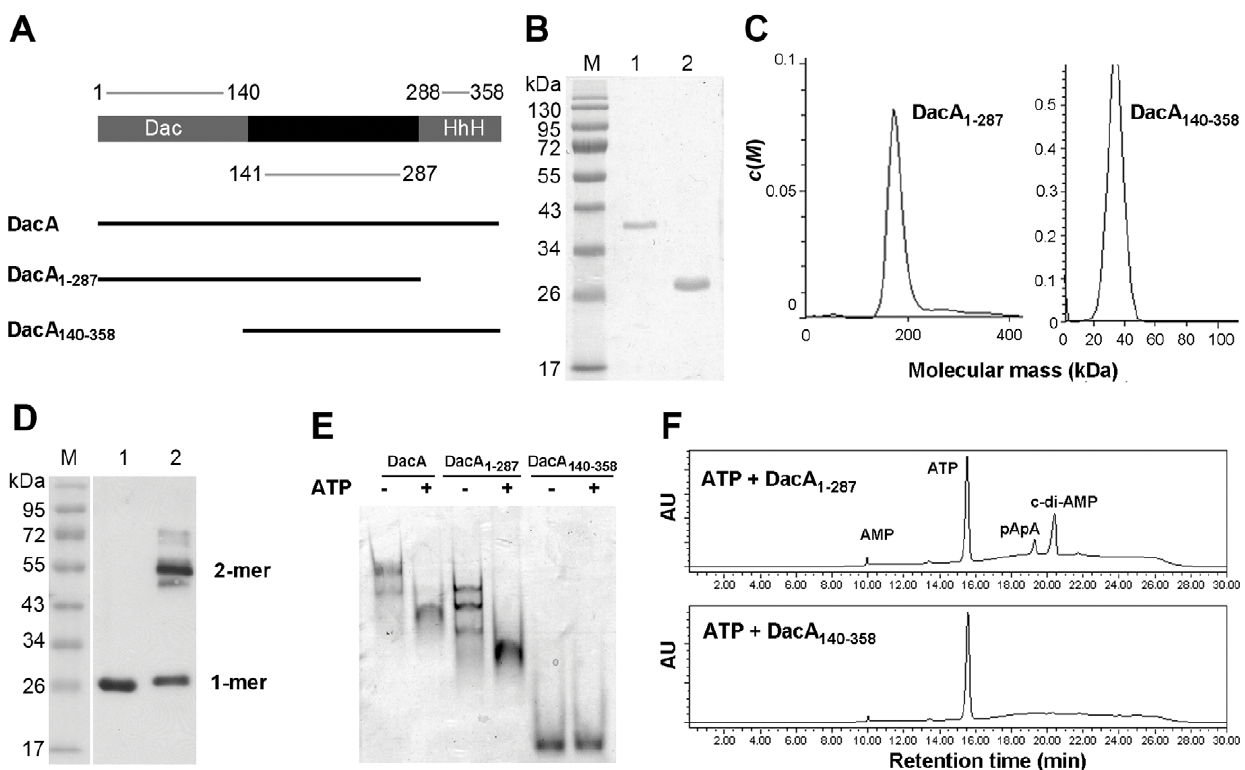
Figure 6. Function of the N-terminal and the C-terminal domains of DacA in oligomerization and enzymatic activity. (A) Schematic representation of the primary structures of DacA, DacA 1–287 and DacA 140–358 , as indicated with black lines. DacA 1–287 lacks the C-terminal HhH domain, while DacA 140–358 lacks the N-terminal Dac domain. (B) SDS-PAGE of purified DacA 1–287 and DacA 140–358 . Lane M, MW marker; lanes 1 and 2 are purified DacA 1–287 and DacA 140–358 , respectively. (C) Analytical ultracentrifugation of DacA 1–287 and DacA 140–358 . (D) Cross-linking of DacA 140–358 with glutaraldehyde. Lane M, MW marker; lane 1, untreated DacA 140–358 ; and lane 2, glutaraldehyde-treated DacA 140–358 . Lanes 1 and 2 were analyzed using Western blot with the anti-DacA antibody. (E) ATP binding by DacA, DacA 1–287 and DacA 140–358 . Proteins, either in the presence ( + ) or absence ( 2 ) of ATP, were separated by electrophoresis with a native gel and stained with Coomassie Brilliant Blue. (F) Enzymatic activity of 10 m M DacA 1–287 and DacA 140–358 analyzed using HPLC.